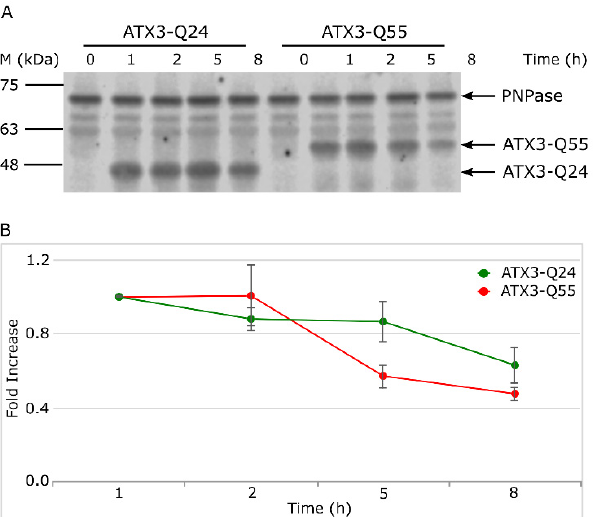
Figure 3. Analysis of soluble protein fraction of ATX3 variants. ( A ) Western blot of soluble fractions of E. coli Rosetta strains expressing ATX3-Q24 and ATX3-Q55. Soluble fractions were collected at different times after induction (t = 0, 1, 2, 5, and 8 h) and processed as detailed in Material and Methods. Black bars indicate the migration of protein markers. Arrows represent the migrations of ATX3-Q24, ATX3-Q55, and PNPase. ( B ) Western blot signals were quantified by densitometry and normalized respect to PNPase signals and t1 signal of each strain. Lines represent ATX3-Q24 (black dots) and ATX3-Q55 (light grey dots) trends. Error bars represent standard error and derive from at least three independent experiments.